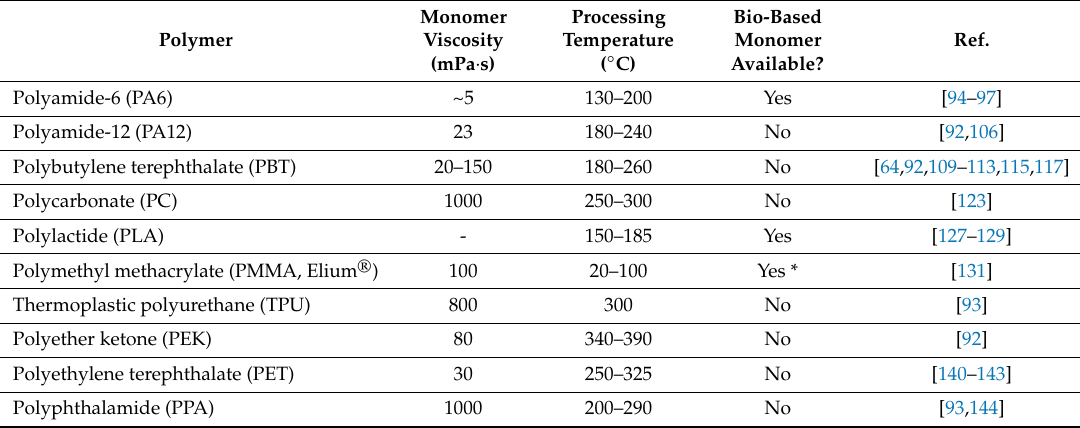
Table 2. Key parameters of thermoplastic monomers for in situ polymerization